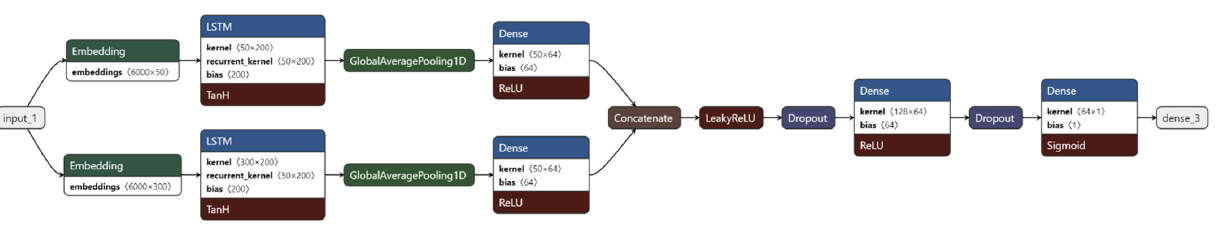
Figure 2. Implemented LSTM ‐ NN.